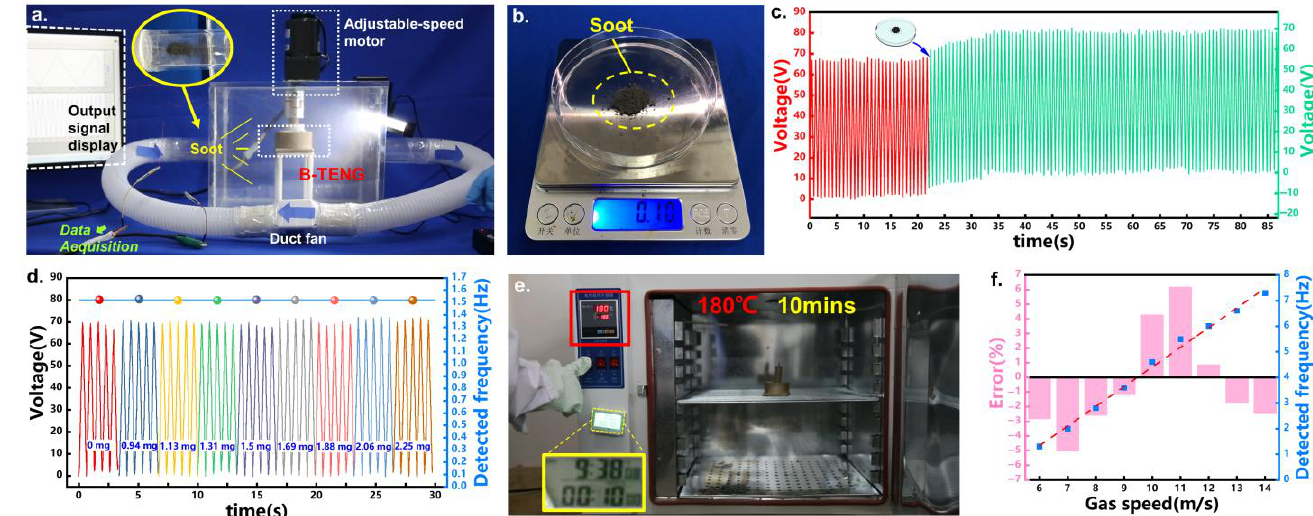
Figure 4. Output performance of the B-TENG under different PM concentration and after heating to 180 °C for 10 min. ( a ) Different PM concentration test system; ( b ) electric balance for weighing PM; ( c ) output voltage of the B-TENG before and after contaminated by PM; ( d ) output voltage and the FFT results of the voltage under different PM concentration; ( e ) heating process of the B-TENG in the heating box; ( f ) output performance of the B-TENG after high temperature heating under different gas speed.